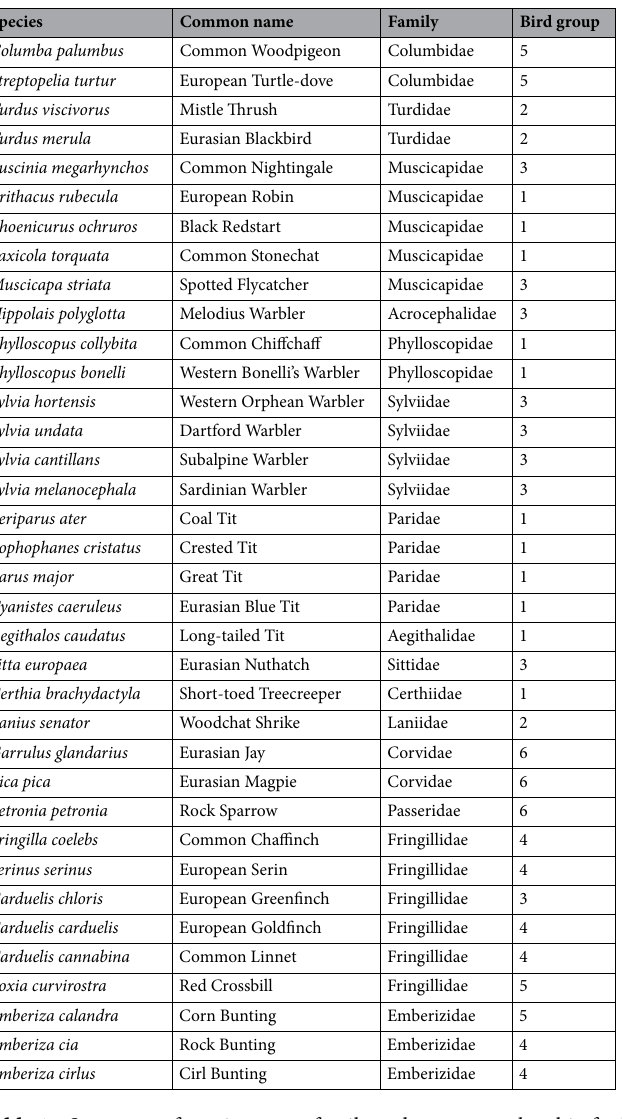
Table 1. Summary of species name, family and group membership for breeding bird species recorded in pond surveys in south-eastern Spain. Bird groups were established based on body size and main diet type: (1) small insectivorous (< 30 g); (2) medium-sized and large insectivorous (≥ 30 g); (3) small insectivorous and frugivorous (< 30 g); (4) small seed-eaters (< 30 g); (5) medium-sized and large seed-eaters (≥ 30 g); and (6) medium-sized and large generalists (≥ 30 g).